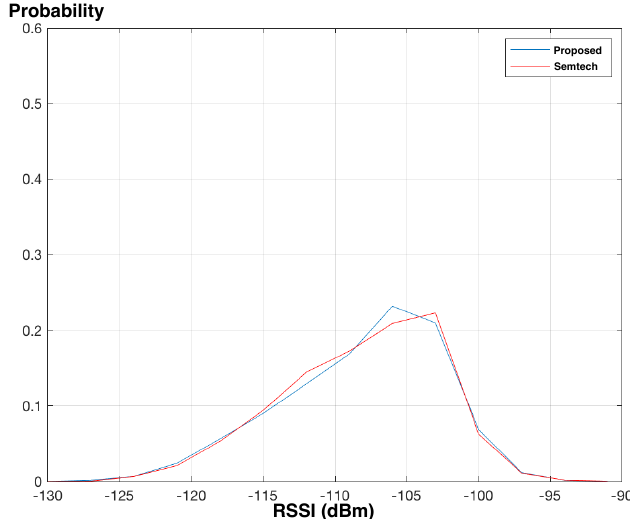
Figure 10. The PRR distribution in B2 floor.